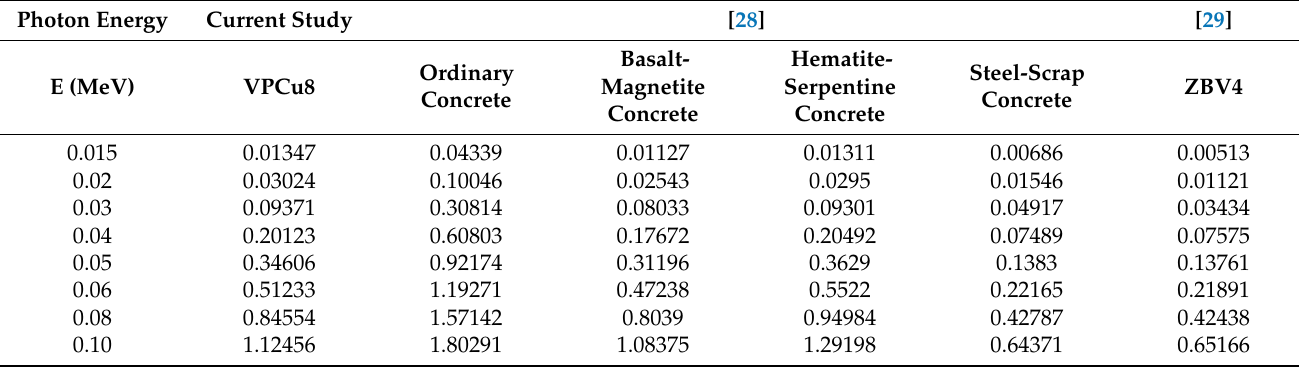
Table 3. Comparison of HVL values for VPCu8 sample with different types of concretes and ZBV4